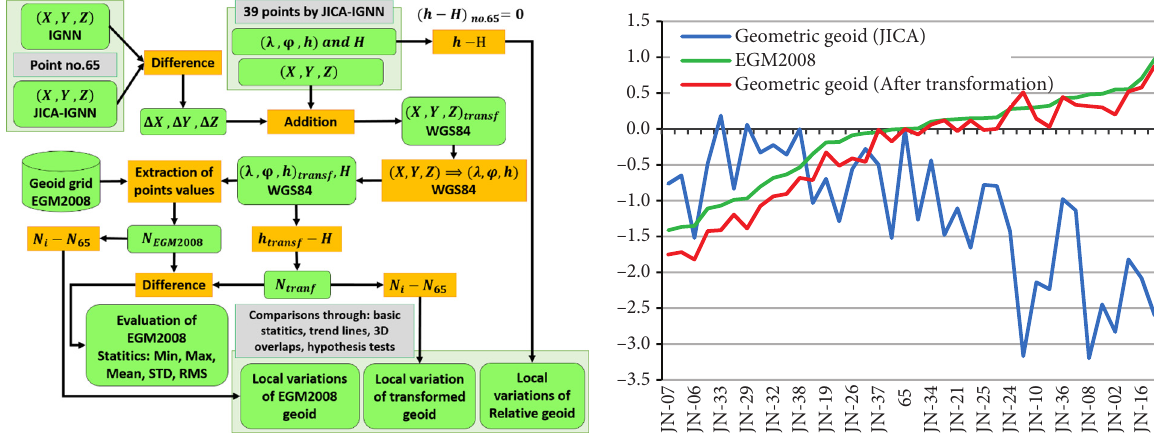
Fig. 6. Full methodology process